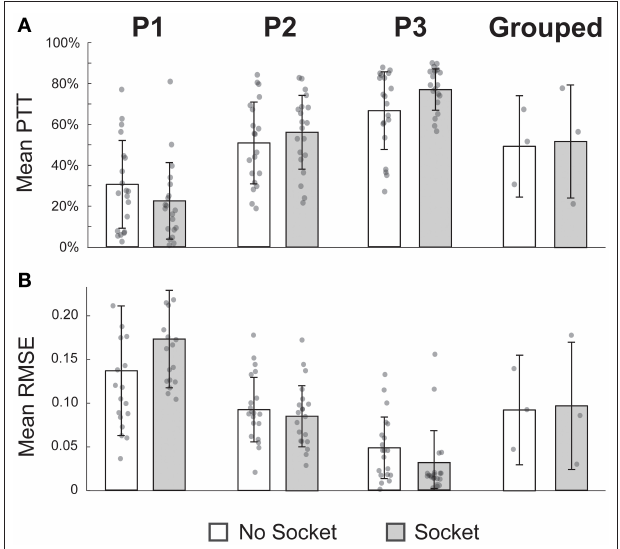
FIGURE 4 | Performance during the target-touching task was not impeded by the socket. (A) Mean percent time in the target region (PTT) was not significantly different while wearing the socket for individual participants nor in the grouped case. (B) Similarly, mean root-mean-squared error (RMSE) was not significantly different when using the socket across the four comparisons. All p -values > 0.05, paired t -tests; N = 20 for each P1, P2, P3 bar; N = 3 for each grouped bar; individual data points are overlayed on each bar.